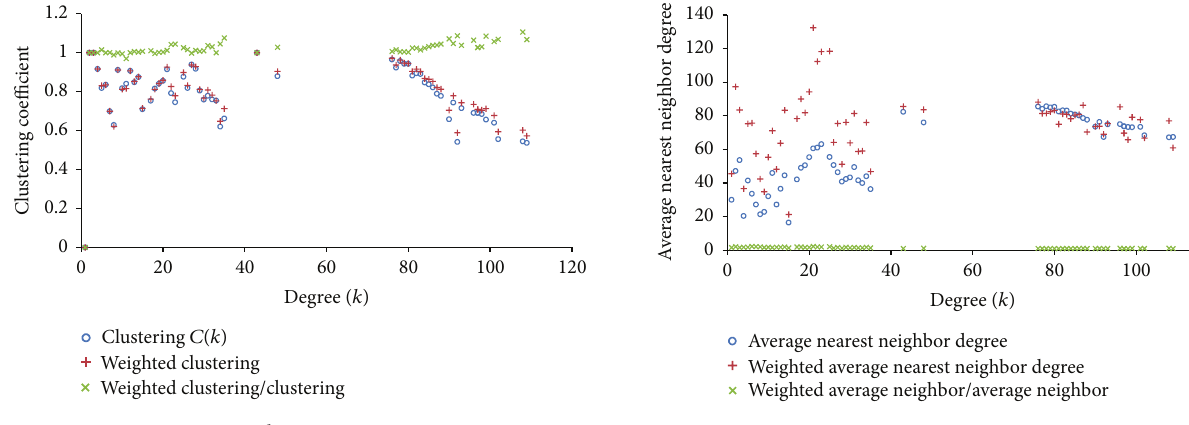
Figure 4: Clustering spectrum. Figure 5: Average degree of nearest neighbors of nodes with degree 𝑘 .